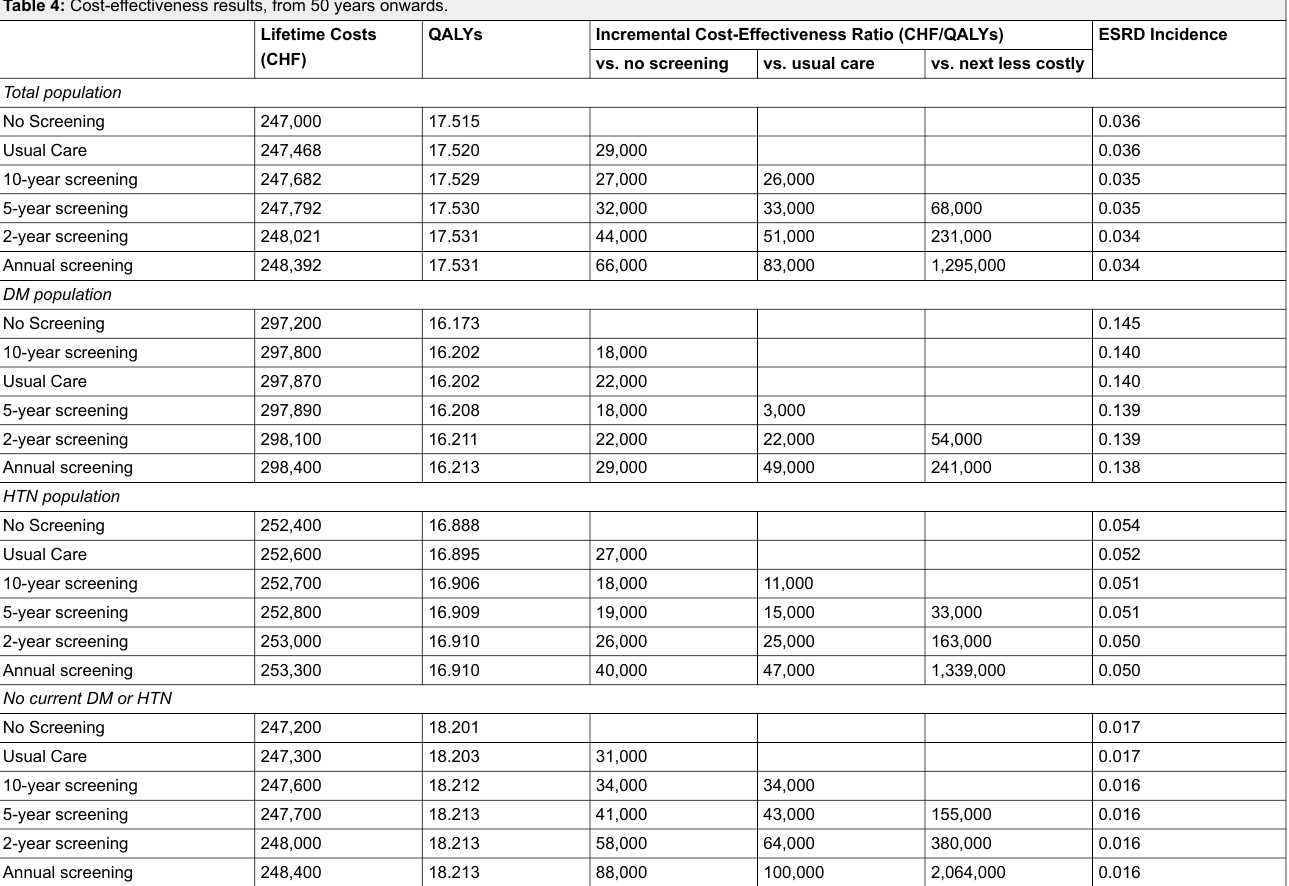
Table 4: Cost-effectiveness results, from 50 years